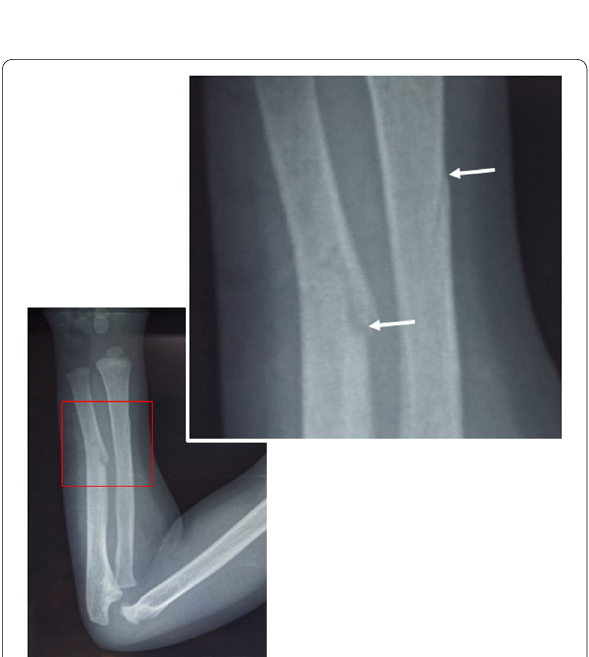
Fig. 2 Greenstick fracture. Lateral x-ray showing unilateral anterior cortical rupture of distal ulna and radius (white arrows), with intact opposite cortical